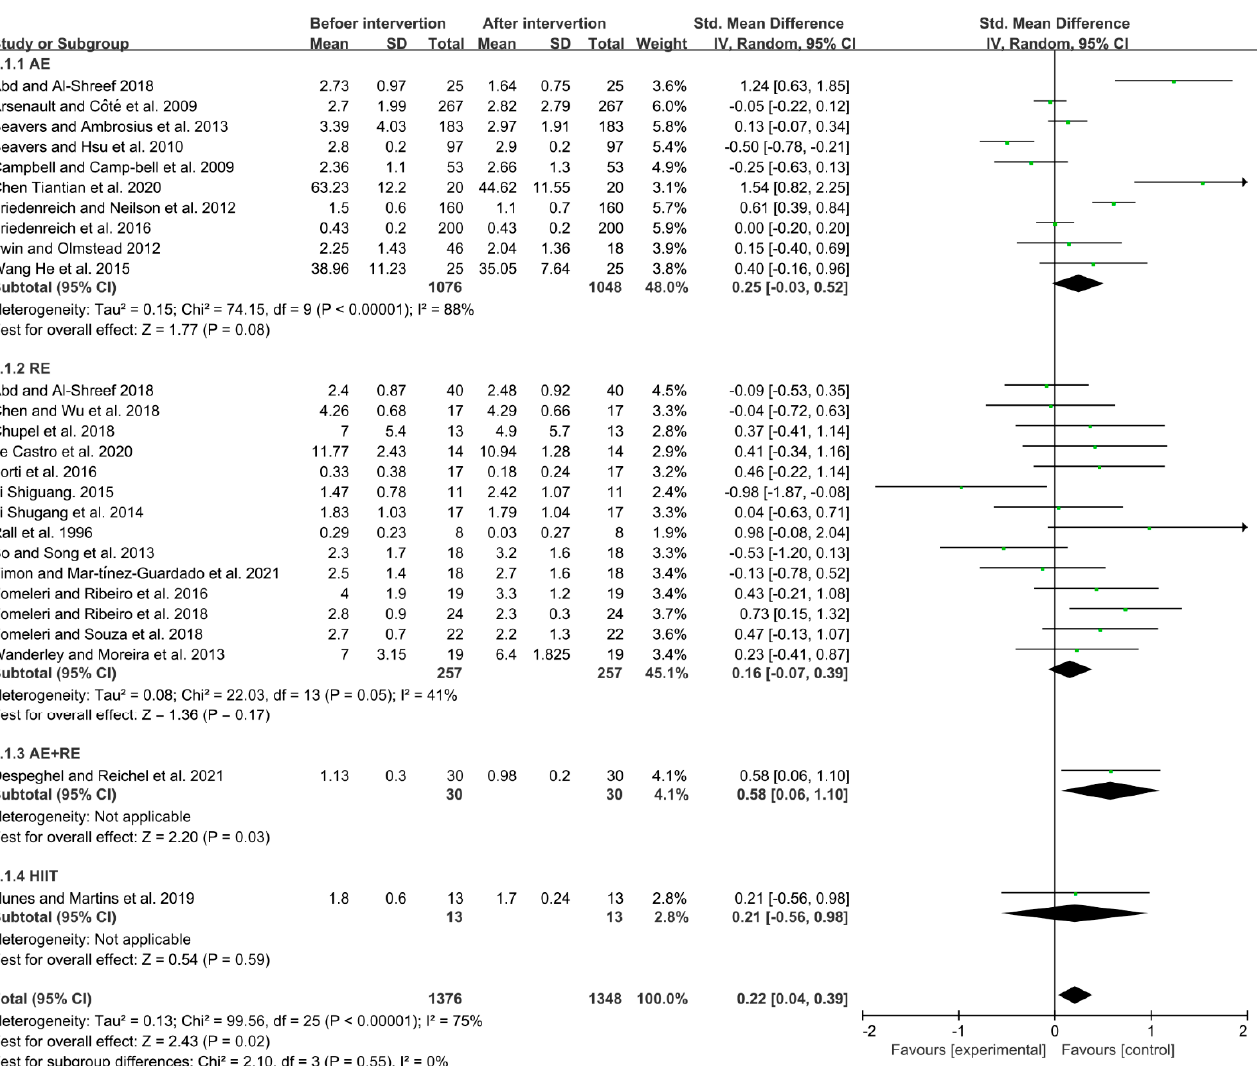
Figure 4. Effects of different exercise modes on IL-6 in the elderly [7,13–19,21,22,24–28,31–34,36,38–